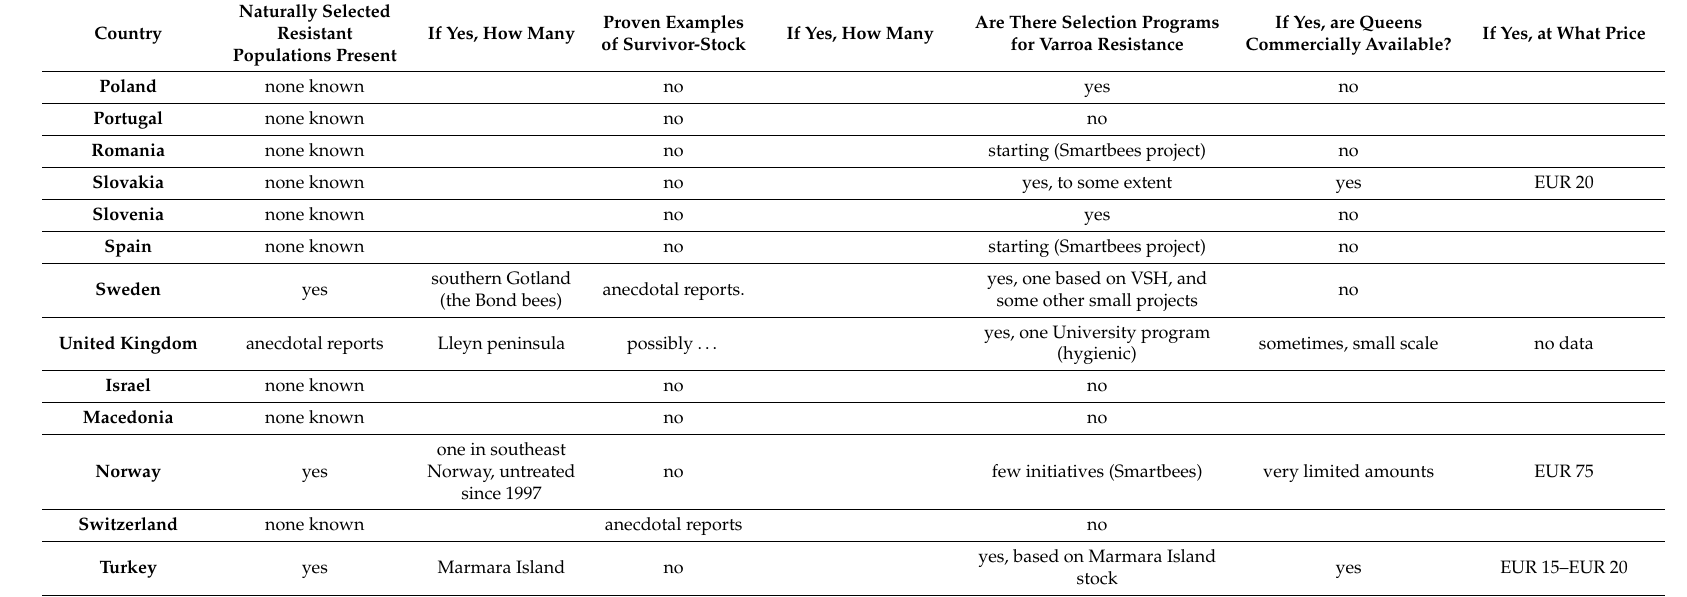
Table 3. Overview of varroa-resistant populations of honey bees in Europe, both naturally selected and from selection programs, and their commercial availability for